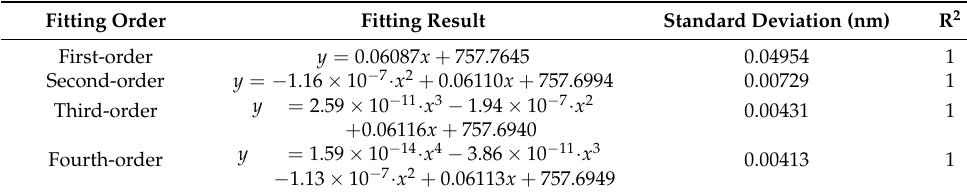
Table 13. Fitting results of the corresponding relationship between the center wavelength of the water vapor absorption band observation channel (channel 6) and the